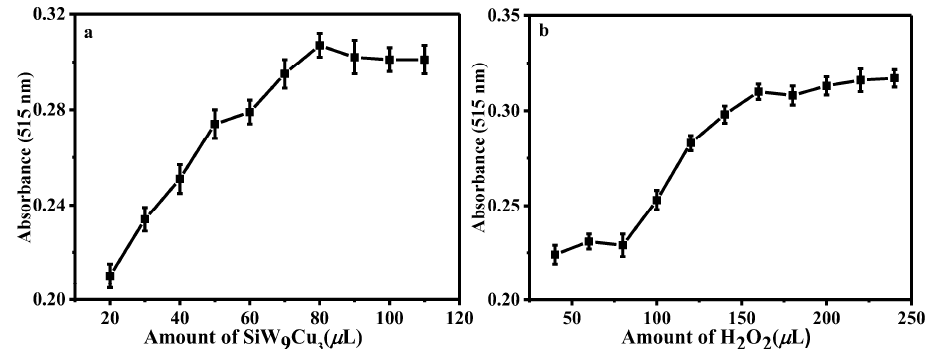
Figure 3. Effect of amount of SiW 9 Cu 3 ( a ) and H 2 O 2 ( b ) in the detection of RAC. ( a ) 100 µ L RAC, 160 µ L H 2 O 2 ; and ( b ) 80 µ L SiW 9 Cu 3 , 100 µ L RAC, and reaction time of 25 min.